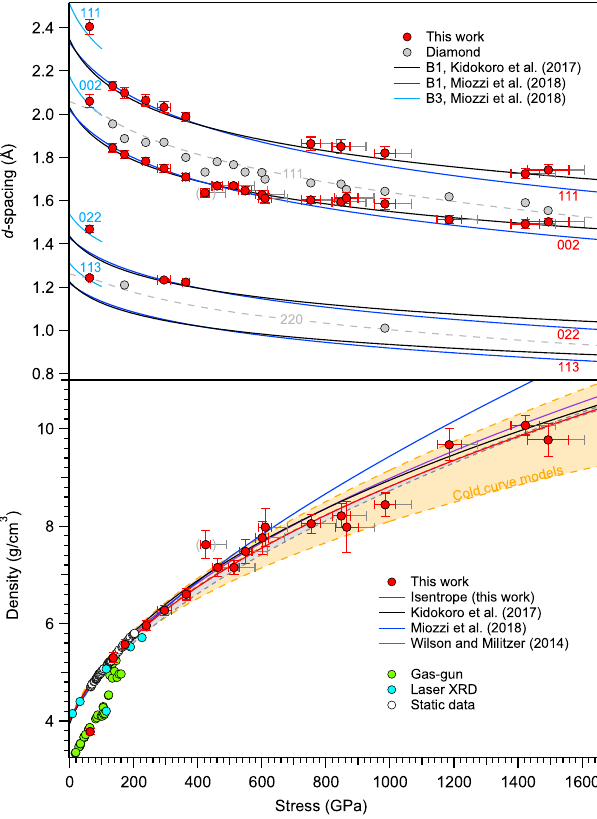
Fig. 5 Measured diffraction peak positions and densities of SiC as a function of stress. a The observed d -spacings of ramp-compressed SiC sample and diamond ablator/window are shown as red and gray circles, respectively. The solid lines are from static 300-K equation of state fi ts and their extrapolation as described below. The diamond ramp equation of state 64 and its extrapolation (>800 GPa) are shown as gray dashed curves. b Measured densities of ramp compressed SiC (red circles) and a Birch- Murnaghan (BM) equation of state fi t to the reduced isentrope (red curve with assumption of Y = 20 GPa and γ 0 = 1) are compared to the extrapolated EOS of diamond anvil cell experiments (blue 20 and black 18 curves) and the range of densities obtained from fi rst principles calculations (orange shaded region 20,26 – 33 , see Supplementary Table 3). The gray band shows the pressure-density path along the principal isentrope calculated using the thermodynamic parameters that are listed in the Suppl. Table 4. Our EOS curve is consistent with the theoretical calculations of ref. 26 (purple curve). Previous shock compression data (cyan 17 and green circle 15,16 ) and static diamond anvil cell data (open circles 18 ) are also plotted. The datum at 433 GPa (gray parentheses) was excluded from fi tting to the EOS (See Suppl. Table 2 for details). The 1 σ error are shown as red bar. Gray error bars represent additional + 50 GPa stress uncertainty due to uncertainty in the strength of